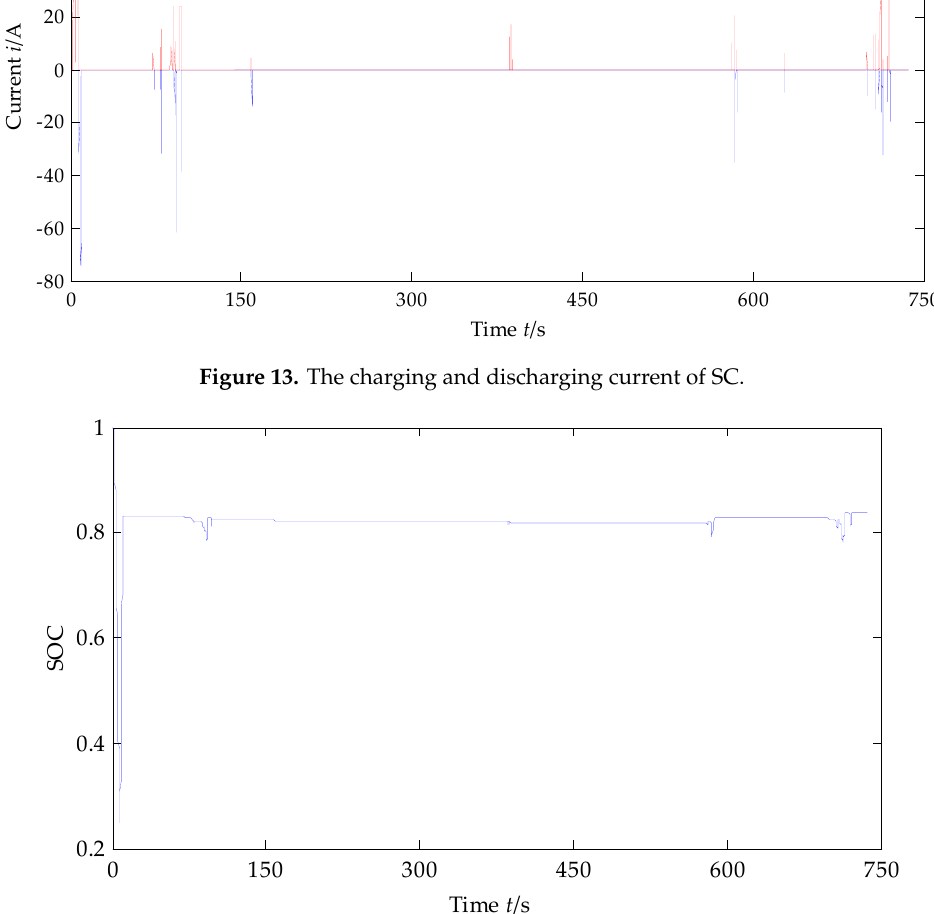
Figure 14. The state of charge (SOC) trend of the super capacitor (SC).